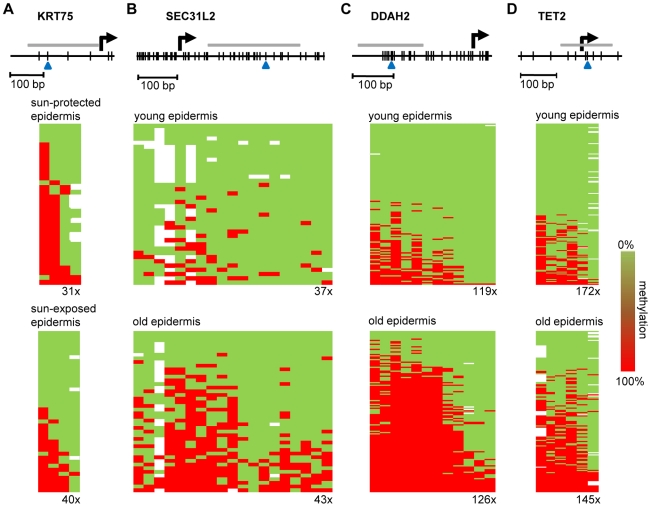
Validation of methylation changes by deep bisulfite sequencing.Schematic outline of the promoter regions of (A) KRT75 (B) SEC31L2, (C) DDAH2, and (D) TET2. Vertical lines represent individual CpG dinucleotides, blue arrowheads indicate CpG markers represented on the array. PCR amplification was performed on equimolar sample pools. PCR amplicons for sequencing are shown as grey horizontal bars, sequencing results are shown as heatmaps. Each row represents one sequence read, individual red boxes represent methylated CpG dinucleotides, green boxes represent unmethylated CpG dinucleotides, sequencing gaps are shown in white. Sequencing coverage ranged from 31x to 172x, as indicated. The deamination efficiency was >99% for all samples analyzed.